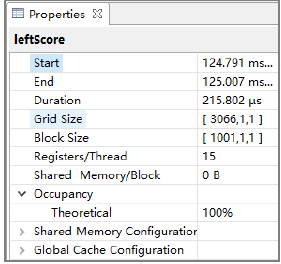
Fig. 9. T he changes of novelty with the increase of λ, Y axis represents novelty and X axis represents λ .